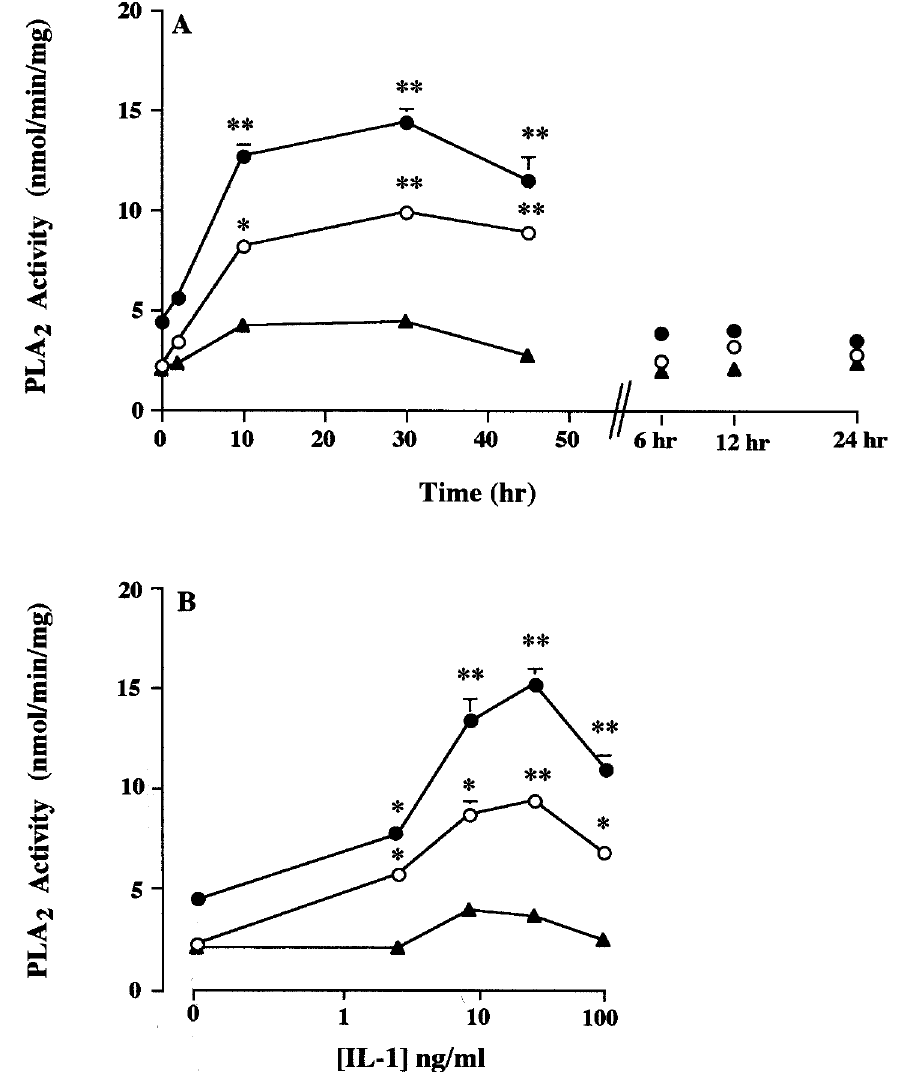
FIG. 5. Activity of total ( d ), secretory ( s ), and cytoplasmic PLA 2 ( m ): (A) in cells treated with IL-1 (10ng/ml) for different time periods, and (B) in cells treated with different concentrations of IL-1 for 10min. * P <0.05, ** P <0.005; P value represents the comparison of the effect of IL-1 on PLA 2 levels as compared with untreated control. Data are means±SE for six separate